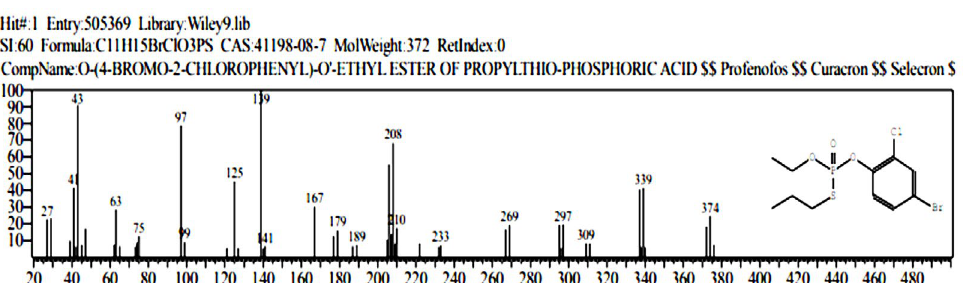
Fig. 10. The chemical compounds O-(4–Bromo–2-Chlorophenyl)-O’-Ethyl Ester of Propylthio-Phosphoric Acid